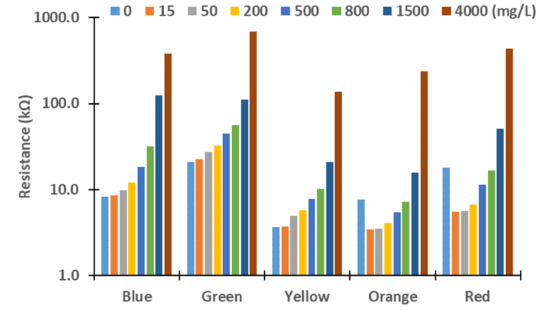
Figure 5. Measured resistance values for algae.